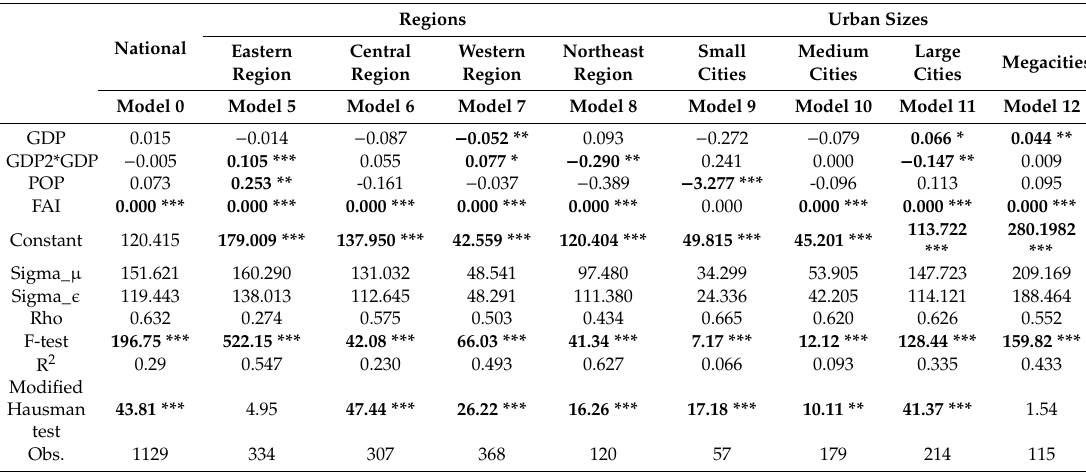
Table 5. Results of panel data models.